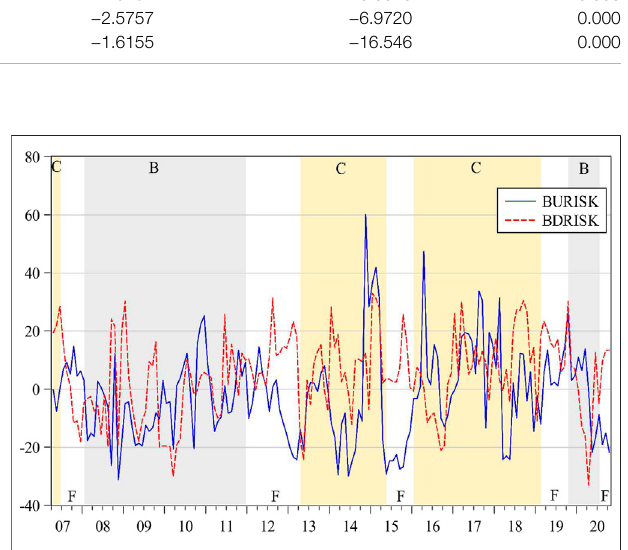
FIGURE 3 | Dynamics of net risk spillover indexes of the international crude oil market in the upward and downward yields. BURISK and BDRISK represent the upside risk and downside risk, respectively. B means that the dual attributes of crude oil are dominant. C means that the commodity attribute of crude oil is dominant. F means that the fi nancial attribute is